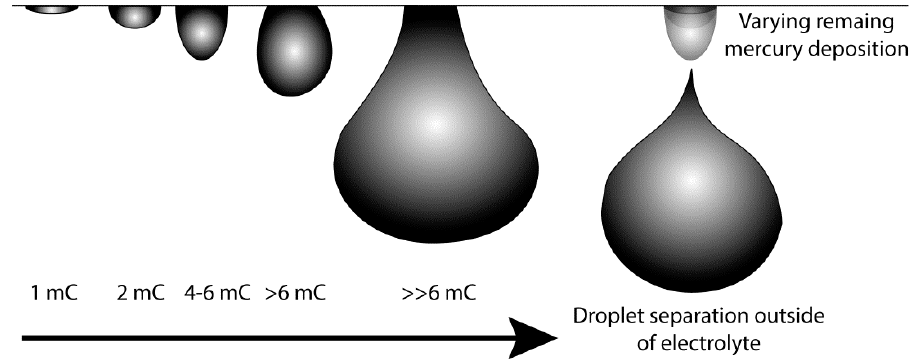
Figure 13. Hypothetical mercury droplet loss after excess plating on a gold electrode surrounded by epoxy resin.